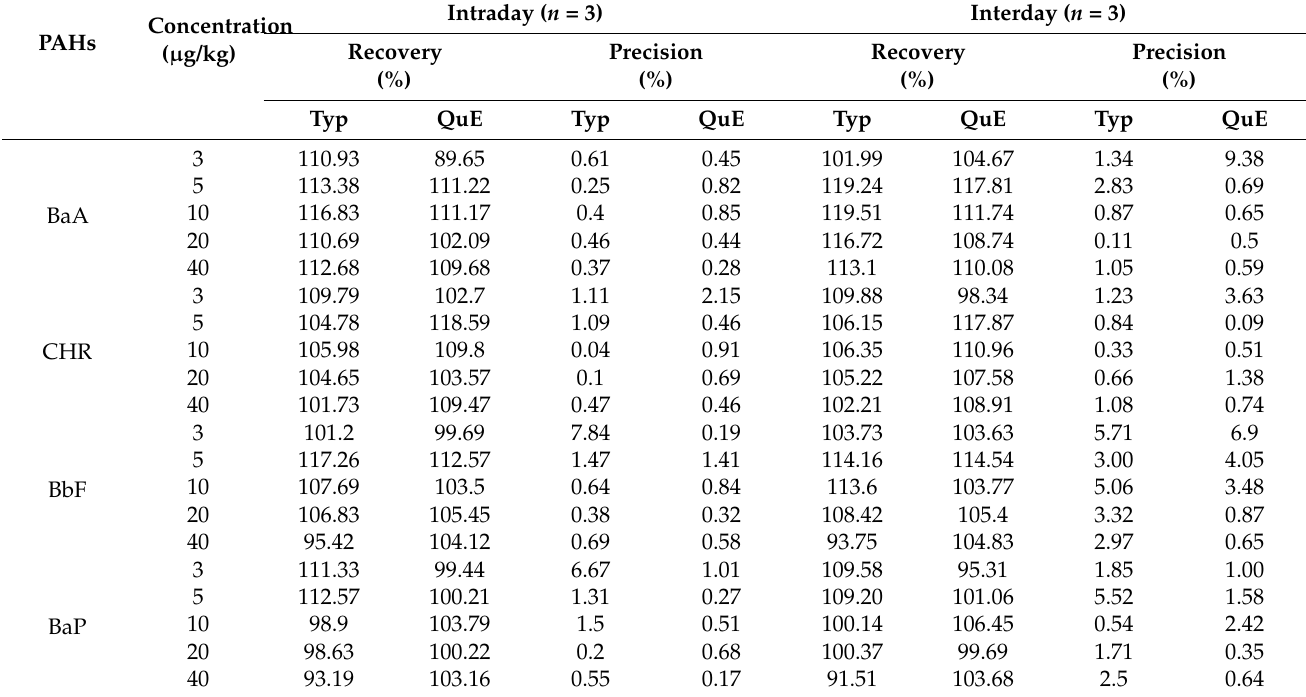
Table 2. Recovery and precision comparison of typical sample treatment and QuEChERS for PAH4 in herbal medicine ingredients.